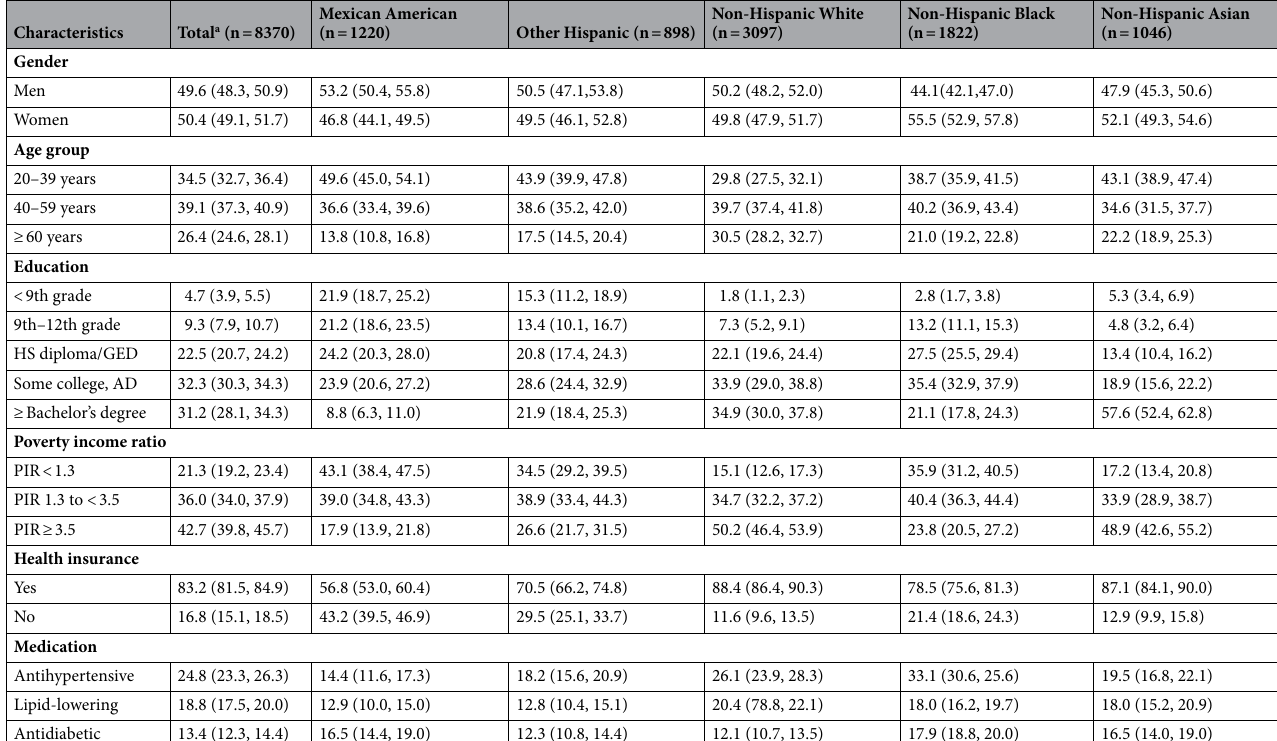
Table 2. Demographic characteristics for adults ≥ 20 years by race/ethnicity. HSD high school diploma, GED general education degree, AD associate degree. Statistics are displayed as Percent (95% Confidence Interval). a All values (except n) are weighted percentages, and age standardized to Census 2010 US